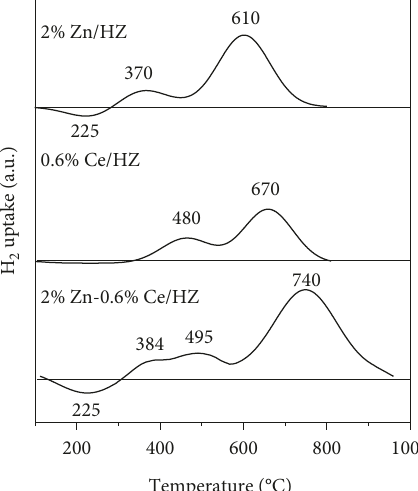
Figure 5: Temperature-programmed reduction (TPR) profiles